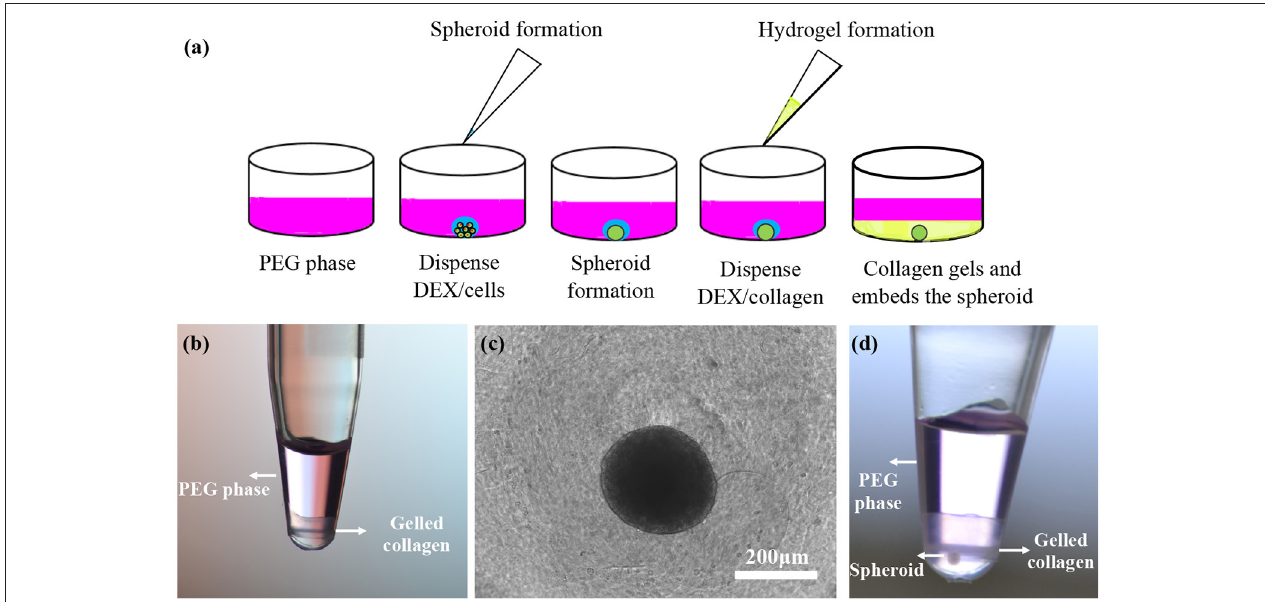
FIGURE 4 | (a) Schematic representation of spheroid formation and embedding in a collagen gel using ATPS in two pipetting steps. (b) A solution of 5 µ L 14% DEX 500k and 5 µ L 4 mg/ml collagen solution was dispensed into 30 µ L of a 6.6% PEG 35k solution. Collagen gelled in the bottom phase during incubation. (c,d) Top and side views of a BT474 spheroid embedded in a collagen gel partitioned to the DEX